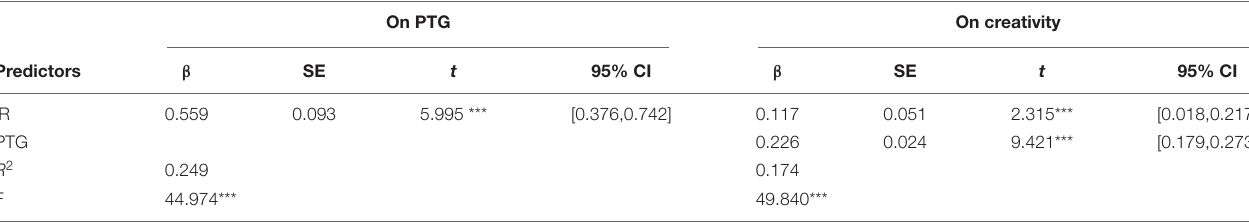
TABLE 3 | Results of testing the moderated mediating effect of post-traumatic growth on creativity. On PTG On